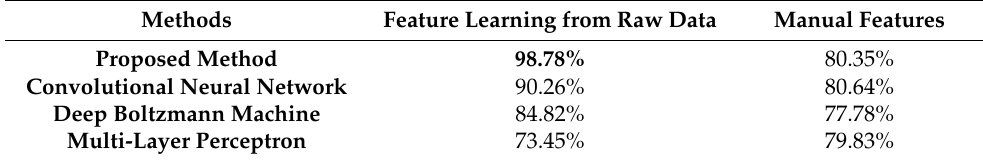
Table 4. Classification accuracy of the suggested method compared with other methods of comparison.